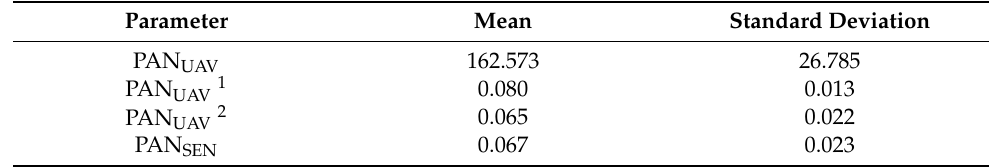
Table 5. Mean and standard deviation for the panchromatic band from UAV (PAN UAV ) and Sentinel- 2A (PAN SEN ).